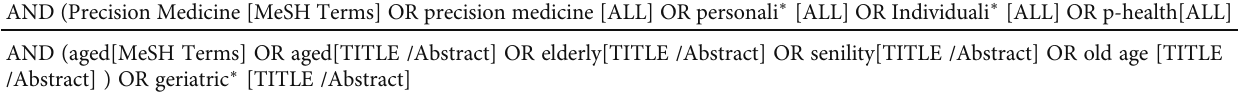
Table 1: PubMed search